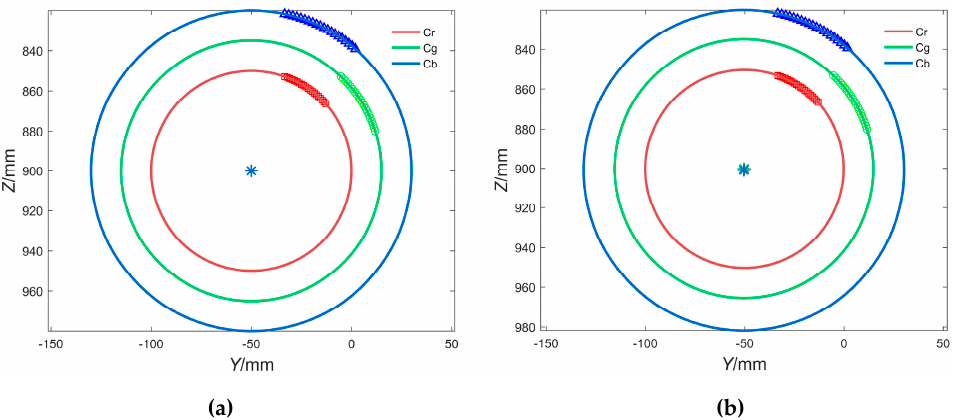
Figure 6. ( a ) Projection of the simulated optical centers on the Y w O w Z w plane without noise; ( b ) projection of the simulated optical centers on the Y w O w Z w plane with 3.5% Gaussian noise. Figure 7. ( a ) Fitted circular curve without noise; ( b ) fitted circular curve with 3.5% Gaussian noise. Table 2. Fitted centers and radii correspondence table.